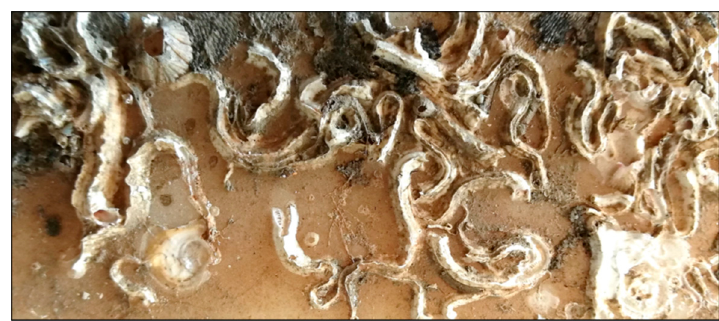
Figure 6. Serpulids ( Spirobranchus sp.) growing on a nylon structure.